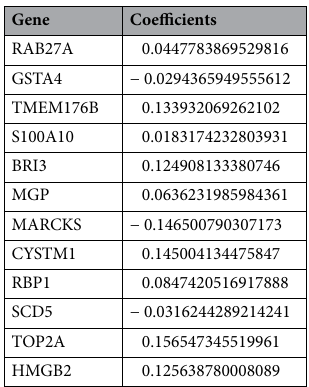
Table 1. Prognostic genes involved in our